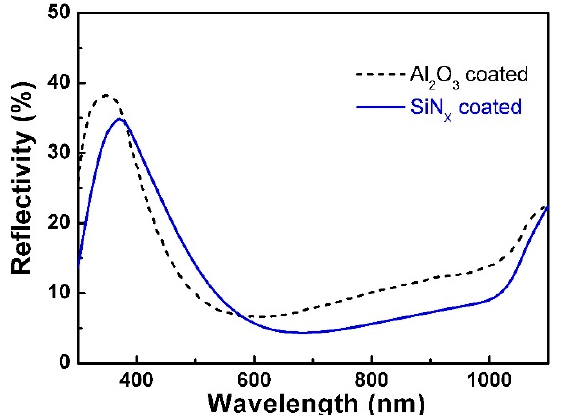
Figure A1. The reflectance of silicon planar solar cells with passivation layers of 80 nm SiN X and 100 nm Al 2 O 3 .